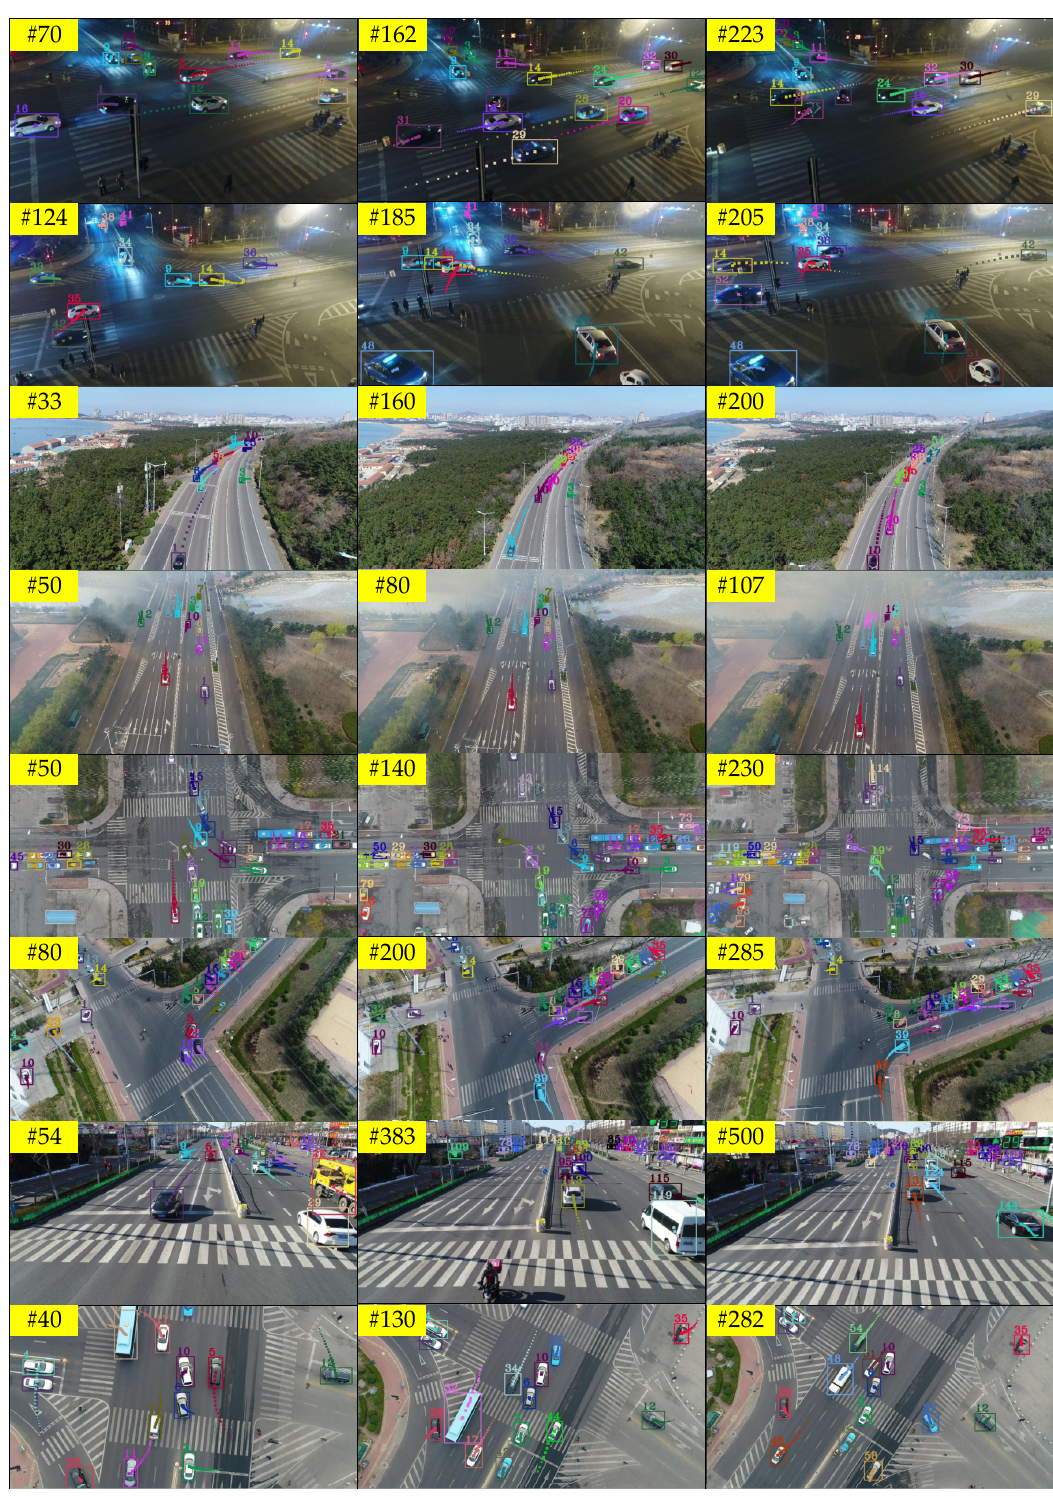
Figure 13. Tracking results of the FPUAV on UAVDT. PTE is designed to capture fine-grained features for accurate localization. The PTE brings gains of 4.8% (32.4–27.6%) on MOTA and 2.4% (41.8–39.4%) on IDF1 for the baseline tracker ( (cid:174) vs. (cid:172) ). Meanwhile, IDS drops from 3029 to 2435. After removing the PTE from FPUAV ( (cid:175) vs. (cid:173) ), MOTA and IDF1 decrease by 2.8% (31.5–34.3%) and 1.1%